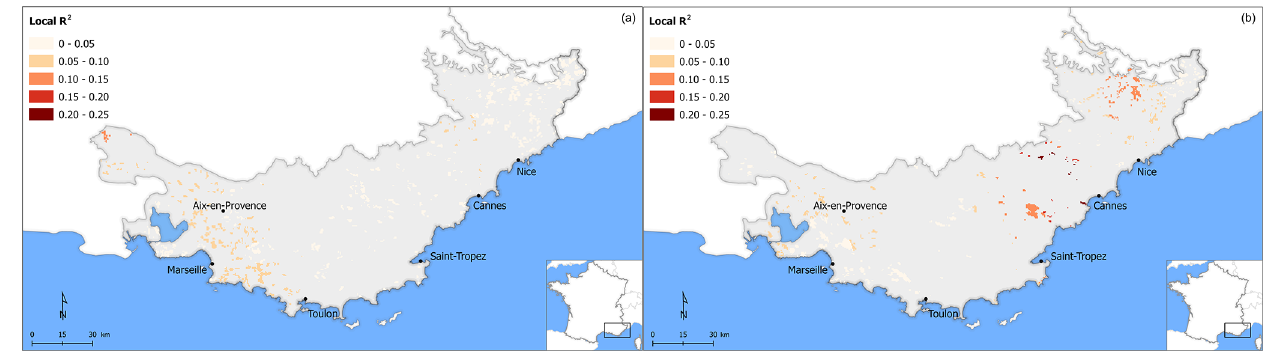
Figure 19. Spatial distribution of local R 2 between the burned area and percent cover of the broadleaved forest for 1970–1994 (a) and 1995–2019 (b) .